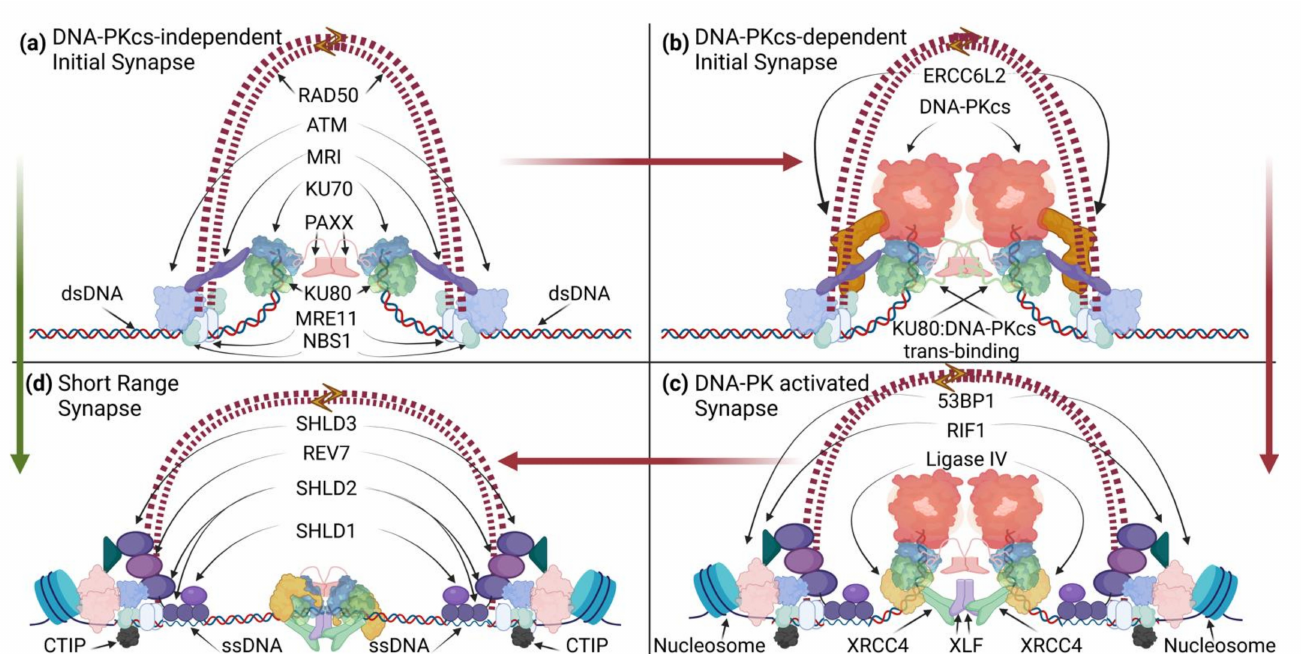
Figure 2. Model for dual-layer DSE pairing by NHEJ/DDR components in the G0/G1 phase. NHEJ proteins hold DSEs at the synapse while MRE11/RAD50 loops support DSE tethering a greater distance away from DNA ends. ( a , b ) Ku binds DSEs. PAXX dimerization may support synapsis across DSEs by KU70 interaction [62–65]. MRI connects KU70 to ATM signaling. Biophysical force transfer between synapsed ends, in response to Langevin Motion [82], signals constitutive twisting and stretching may activate ATM autophosphorylation and stabilize MRE11/RAD50 DNA binding through NBS1. ( b ) DNA-PKcs binds to Ku at end termini to form the DNA-PK holoenzyme. The C-terminal alpha helix of KU80 becomes bound to the opposite DNA-PKcs subunit to complete trans domain swapping and dimerization [27]. Stretching and twisting may prime for DNA-PK activation [31]. The presence of ERCC6L2 supports NHEJ functions, potentially in collaboration with MRI. ( c ) XLF dimer recruitment connects each DSE to flanking XRCC4 dimers and Ligase IV on each side [28,30]. The conformational shift reverts KU80 domain swapping, enabling ATM to activate DNA-PK and for DNA-PK to attenuate ATM activity to support NHEJ. NBS1/ATM chromatin signaling ultimately recruits 53BP1, RIF1, and the shieldin complex (SHLD1, SHLD2, REV7, and SHLD3) [83]. Biophysical detection of pairing may signal to commit to NHEJ. ATM phosphorylates CTIP (black, see ( d )) to stimulate MRE11 nuclease activity. DNA-PK enables MRE11 endonuclease activity [32] to expose ssDNA for SHLD2 OB-fold domain binding (depicted here with 3 (cid:48) strand nicking instead of 5 (cid:48) strand nicking proposed for S/G2). ( d ) Complete DNA-PK trans autophosphorylation releases DNA-PKcs from the synapse, enabling transition to the short-range synapse [28,30]. Ligase IV becomes poised for ligation in a “close” synapse [36,84]. Note that NHEJ factors from ( a ) can readily proceed to the short-range configuration (green arrow; see ( d )) in the absence of DNA-PKcs but may not be coordinated with MRN complex